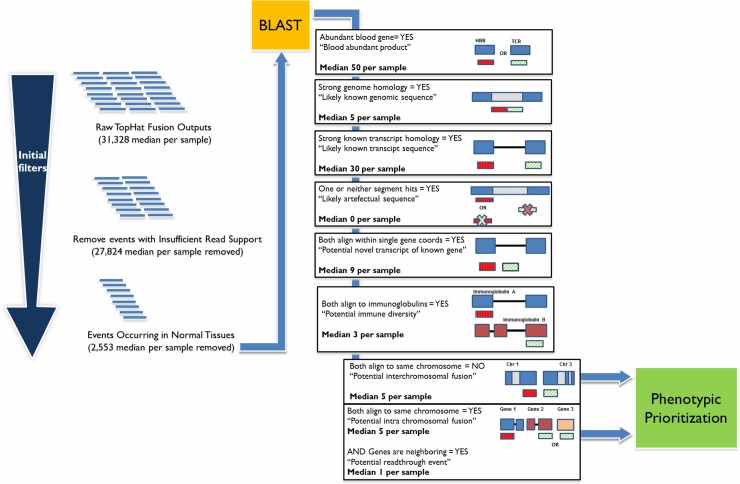
Fusion categorization workflow and median number of fusion candidates per category.Unfiltered results from TopHat fusion were BLASTed, annotated and input into the candidate classification workflow. The median number of events per sample in each category is shown. All candidates classified as potential fusions or read-through events, proceeded into a final review stage that determined phenotypic relevance of the genes to the patient condition using both automated PCAN analysis and manual review. Candidates classified as most phenotypically relevant were selected for follow-up validation.